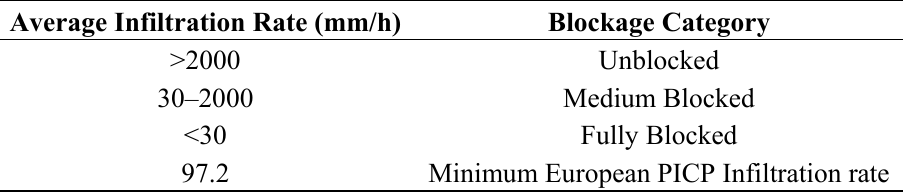
Table 1. Categories of pavement blockage and associated infiltration